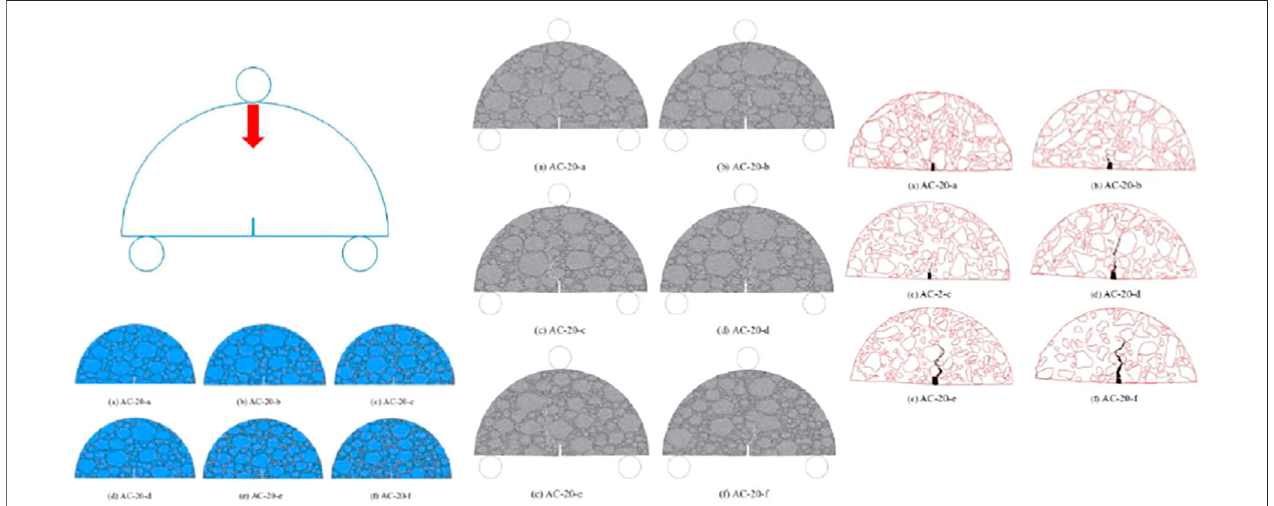
FIGURE 9 | SCB digital samples, loading setting and deformations of the asphalt mixtures (Liang et al., 2021; Nian et al., 2021).